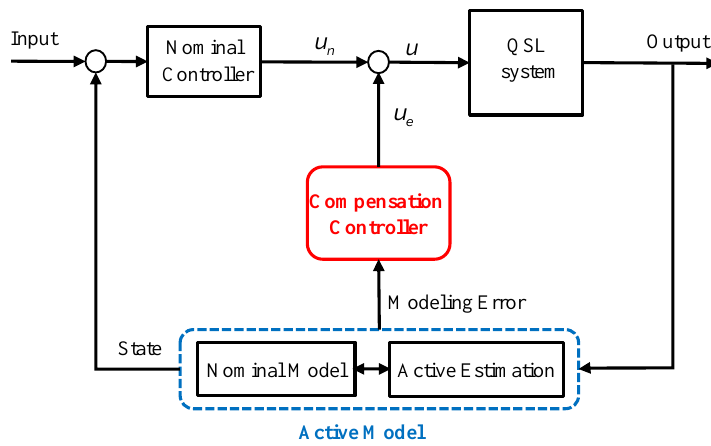
Figure 1. Scheme of the active-model-enhanced